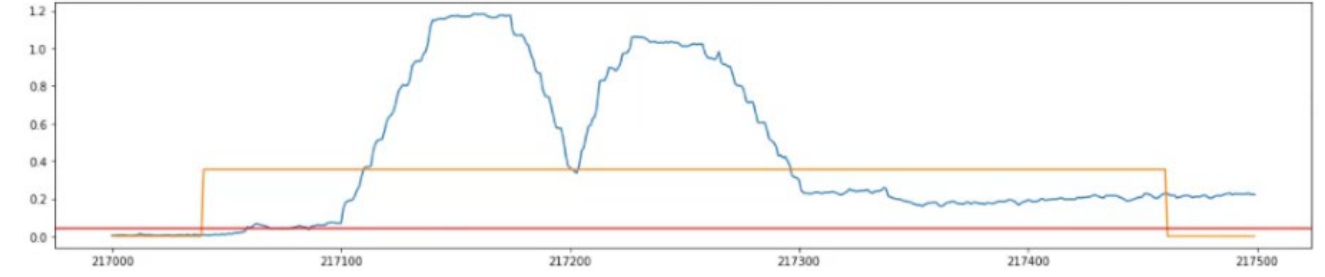
Figure 13. Section 4: 217,000~217,500 (Attack 27). The red line is the threshold, and when the blue line crosses the red line, we predict an attack. The orange line is the actual attack range.